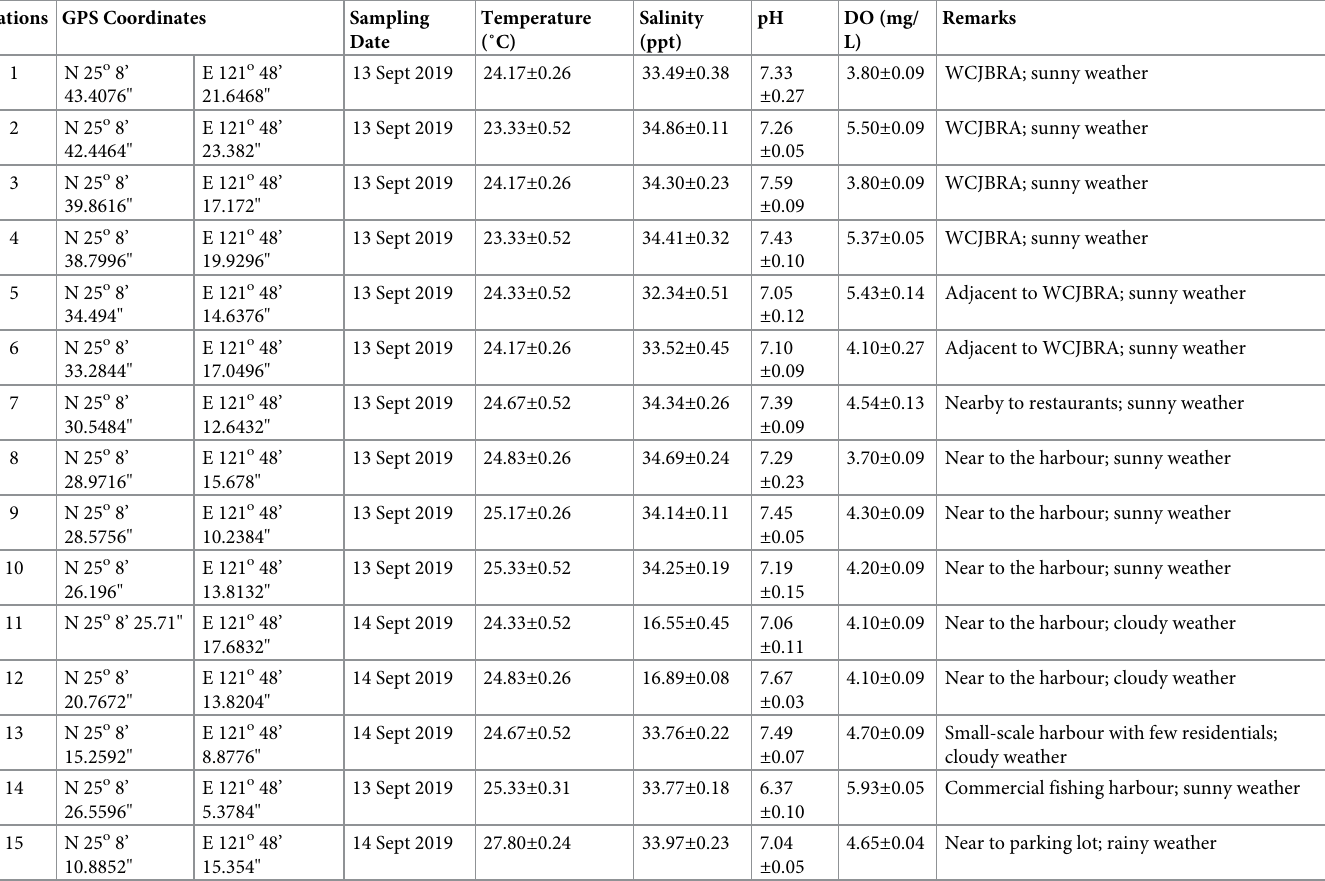
Table 1. Sampling regime and GPS coordination in Chaojing Park, Keelung,